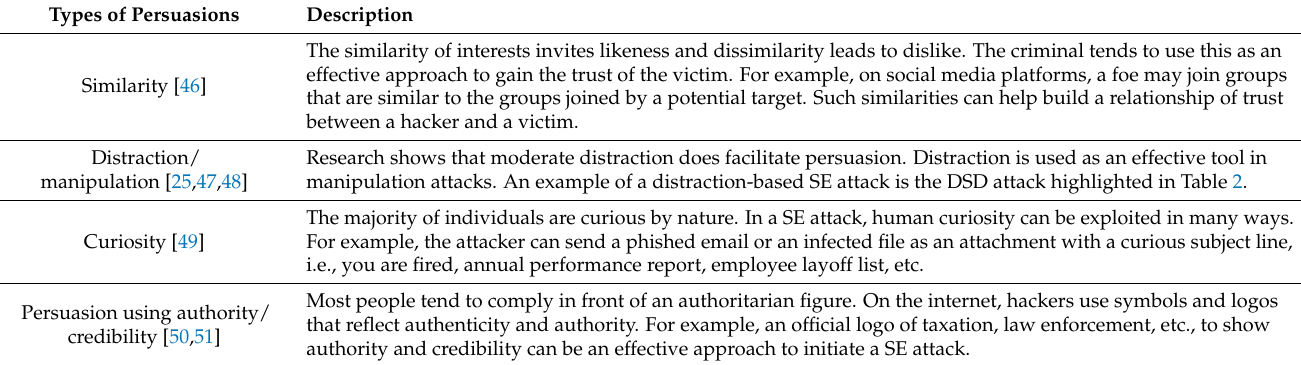
Table 4. Persuasion types used in social engineering attacks.